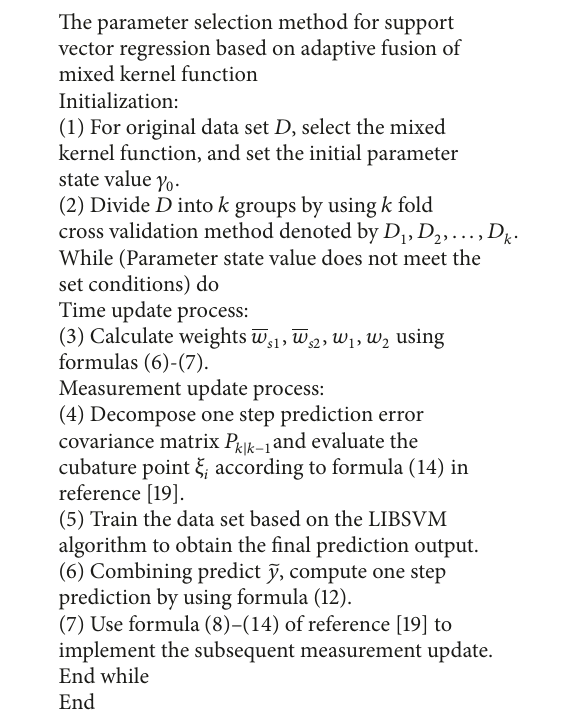
algorithm of the parameter selection method for